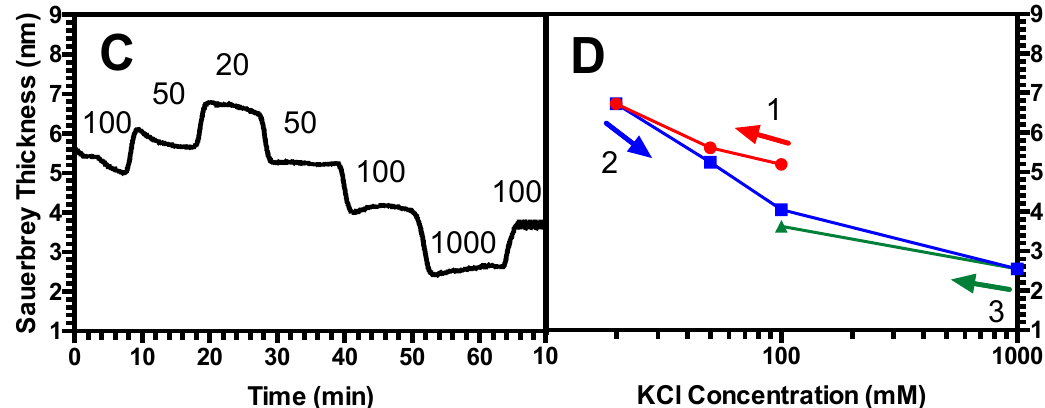
Figure 6. ( A ) Representative swelling response for a 2 kDa PAA brush, grafting density σ = 0.87 at fixed, neutral pH with varying KCl concentration in mM (values given in plots). ( B ) Average swelling vs. KCl concentration. ( C ) Representative swelling response for a 39 kDa PAA brush, grafting density σ = 0.023 at fixed, neutral, pH = 7 with varying KCl concentration in mM (values given in plots). ( D ) Average swelling vs. KCl concentration. Note that in ( C , D ), that the first and final salt concentration are the same and lie near the middle of the x axis at 100